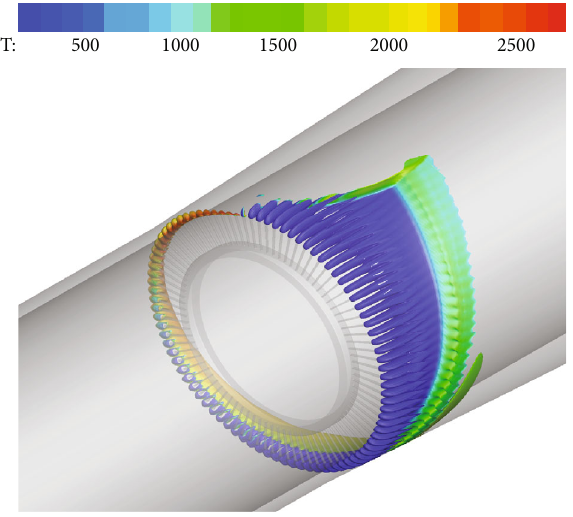
Figure 8: Fuel mass fraction isosurface of 0.03 colored by the temperature of case 1.